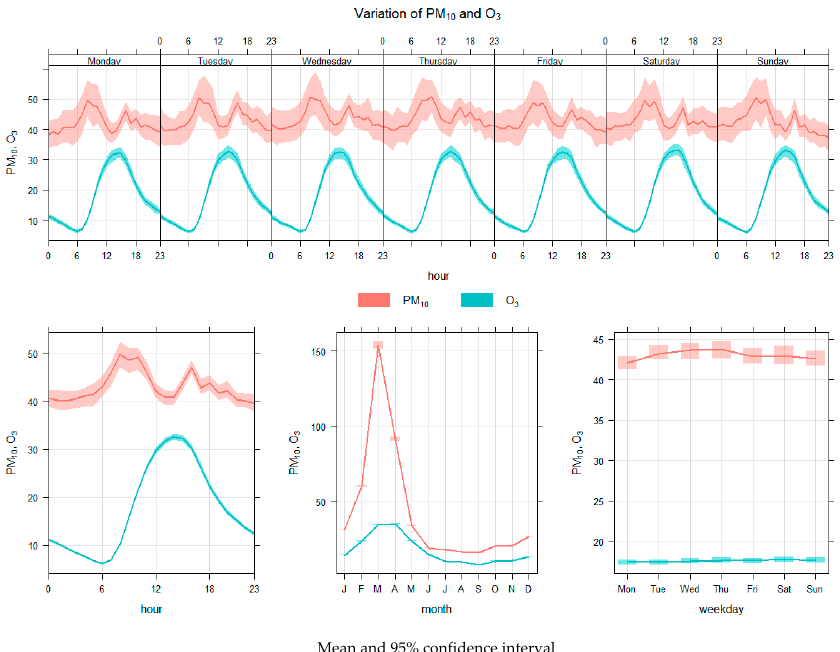
Figure 6. Variations in PM 10 and O 3 concentrations over hourly, daily, and monthly periods.